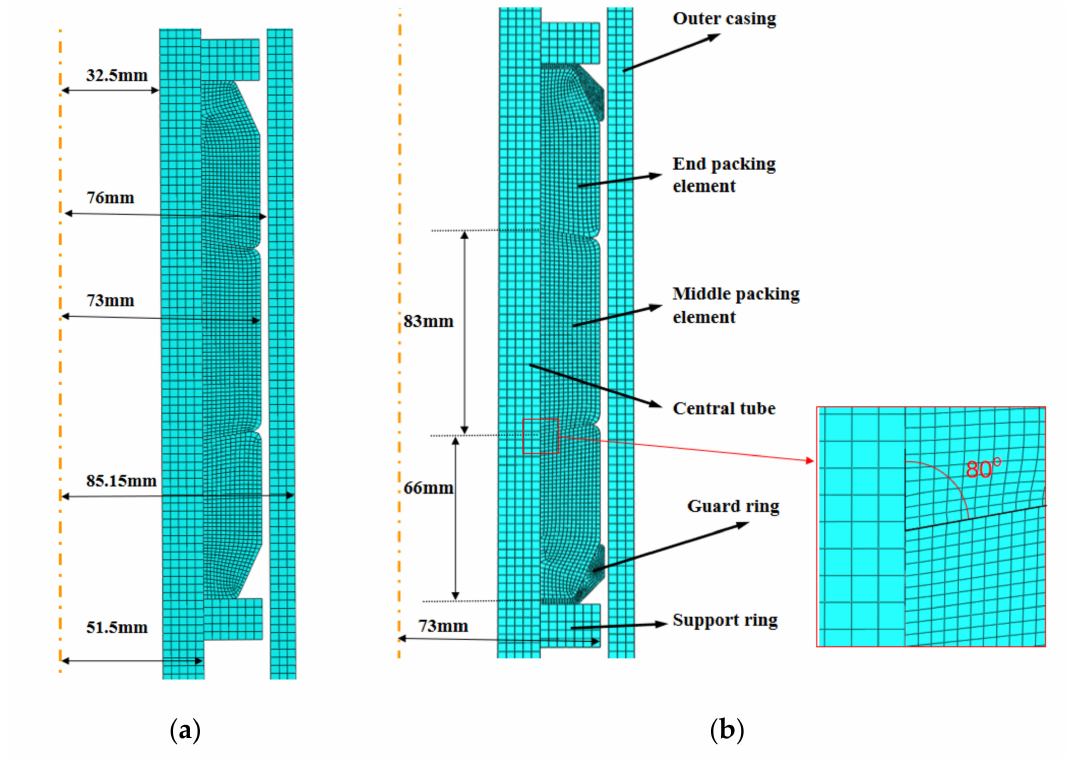
Figure 3. Schematic diagram of rubber packing element model. ( a ). Schematic diagram of rubber packing element without guard ring. ( b ). Schematic diagram of rubber packing element model with guard